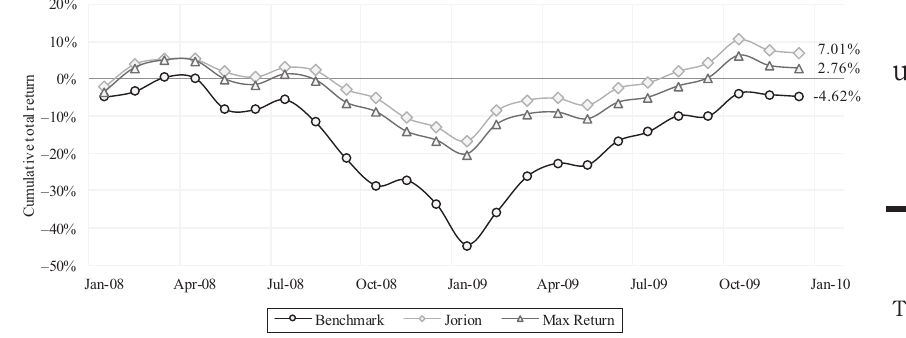
Figure 9. Cumulative return,